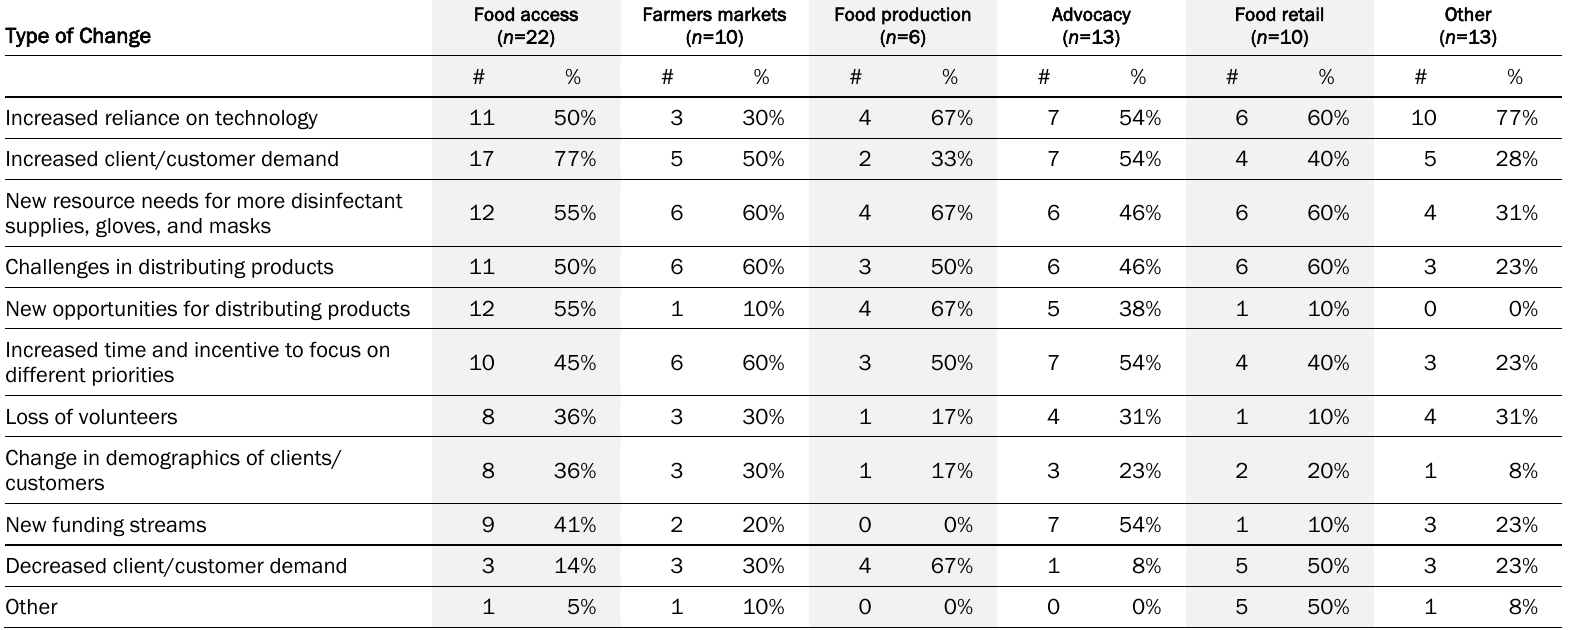
Table 2. Pandemic Impacts According to Sector Type of